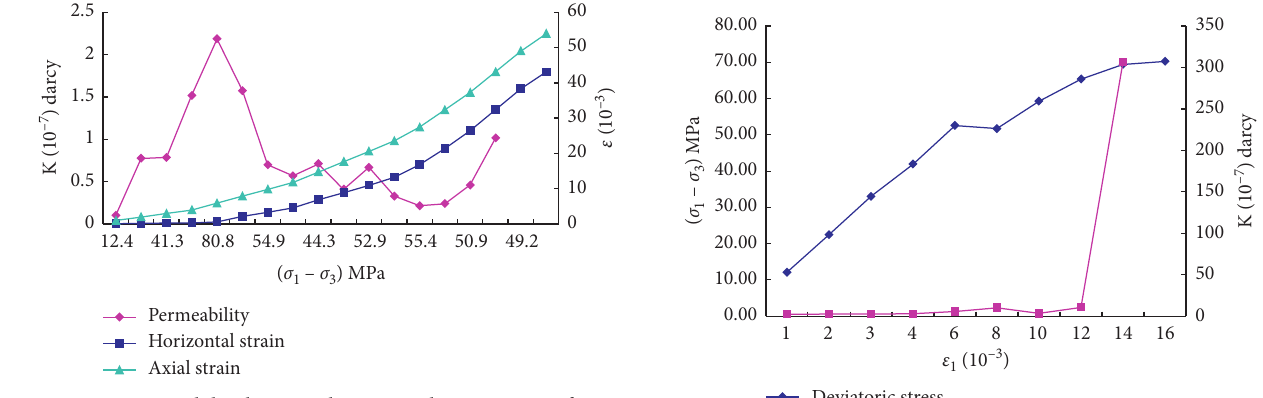
Figure 10: Permeability-horizontal strain-axial strain curves of A3-2.